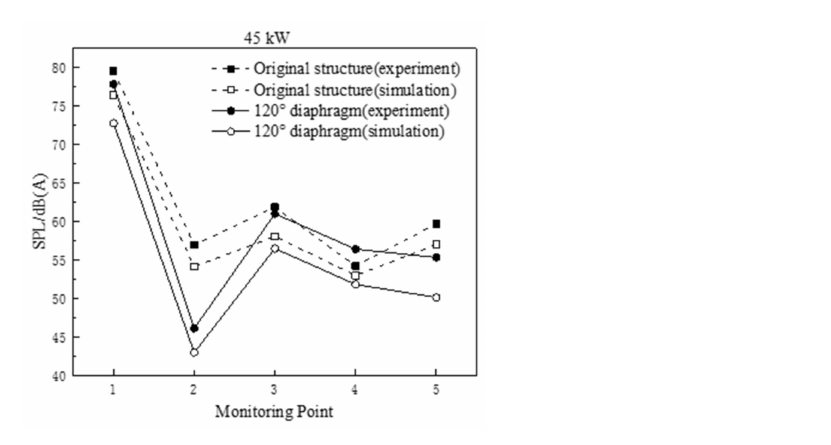
Figure 16. Comparison of sound pressure level between 120 ◦ structure and original structure (experiment and